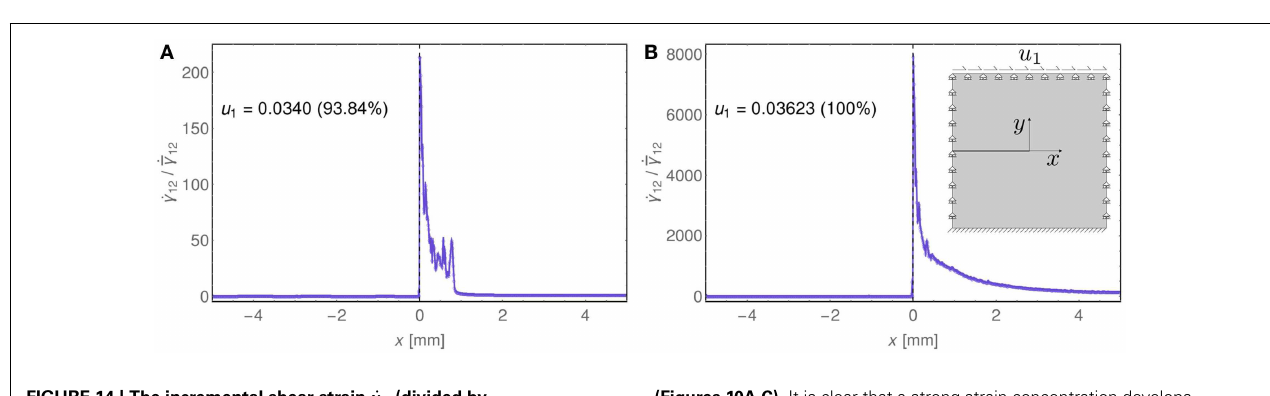
FIGURE 14 | The incremental shear strain ˙ γ 12 (divided by (Figures 10A,C) . It is clear that a strong strain concentration develops at the tip of the shear band, which becomes similar to the square-root the mean incremental shear strain ˙¯ γ ) along the x -axis at 12 singularity that is found with the perturbative approach (Section 4 and the two stages of deformation, (A) u 1 = 0.0340 mm and (B) u 1 = 0.03623 mm, reported in Figure 10 and labeled there as Figure 16